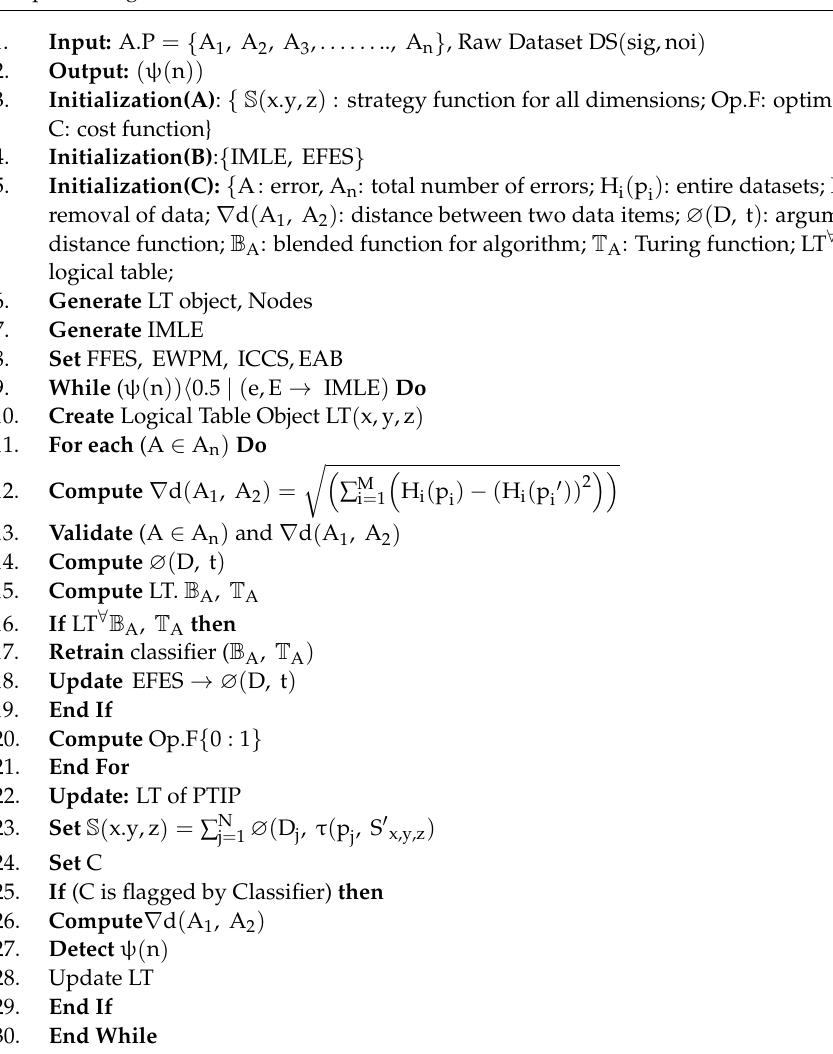
Algorithm 1: Inaccuracy removal ψ ( n ) in logical table for development of pre-processing